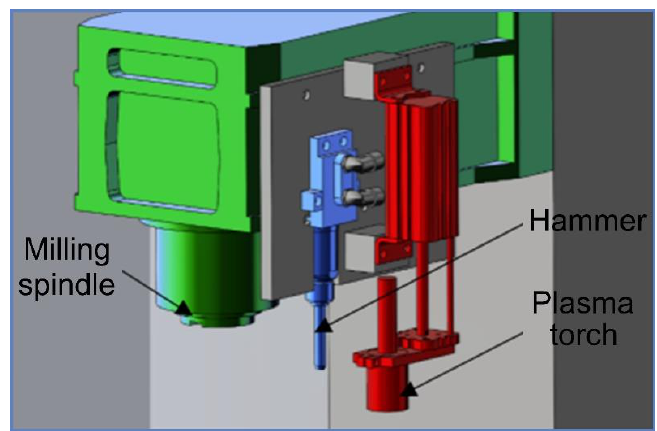
Figure 2. Principle of the facility for implementing Plasma-MIG hybrid welding and layer-by-layer peening.